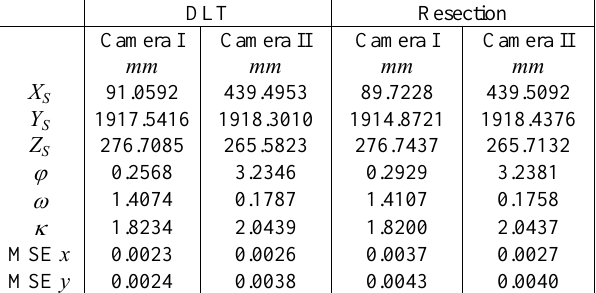
Table 2. The Result of Multi-Image Resection